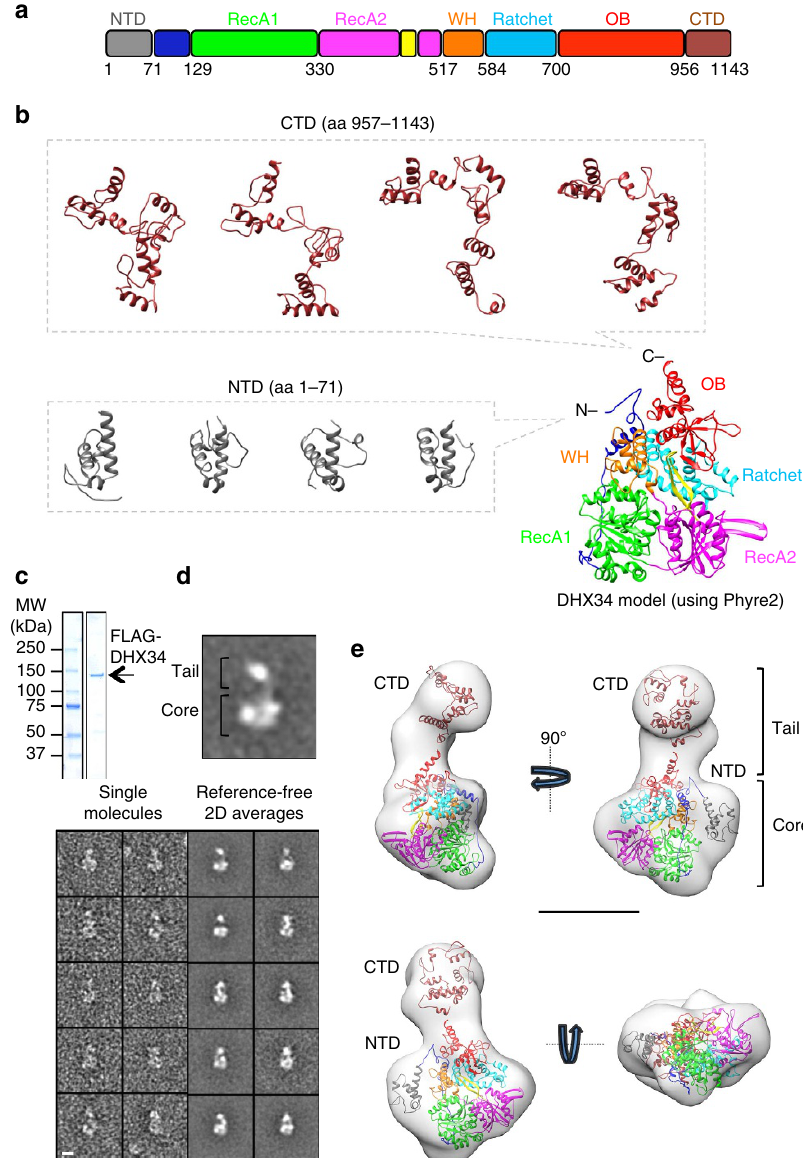
Figure 1 | Architecture of DHX34 helicase. ( a ) Cartoon depicting the functional domains of DHX34, showing residue numbers that define their boundaries. Names for domains are borrowed from the structure of Prp43 (ref. 40,41) and based on the predictions obtained using PHYRE2 (ref. 39). NTD, RecA1, RecA2, winged-helix (WH), Ratchet, OB-fold and CTD domains are shown. The RecA2 domain contains a small antiparallel b - hairpin shown in yellow. ( b ) Atomic modelling of DHX34 obtained using PHYRE2 (ref. 39), including the low-confidence predictions for the NTD and CTD. ( c ) SDS–PAGE (4–15%) of purified FLAG-DHX34 used for the structural analysis. One microgram of FLAG-DHX34 was loaded and stained with SimplyBlue SafeStain (Novex). ( d ) Gallery of selected single molecules of DHX34 observed using EM, as well as reference-free two-dimensional (2D) averages. Scale bar, 10nm. One representative average has been amplified, and the Tail and Core regions indicated. ( e ) Four views of the 24-Å resolution EM structure of DHX34, shown as a transparent density, where the atomic predictions have been fitted. Scale bar,